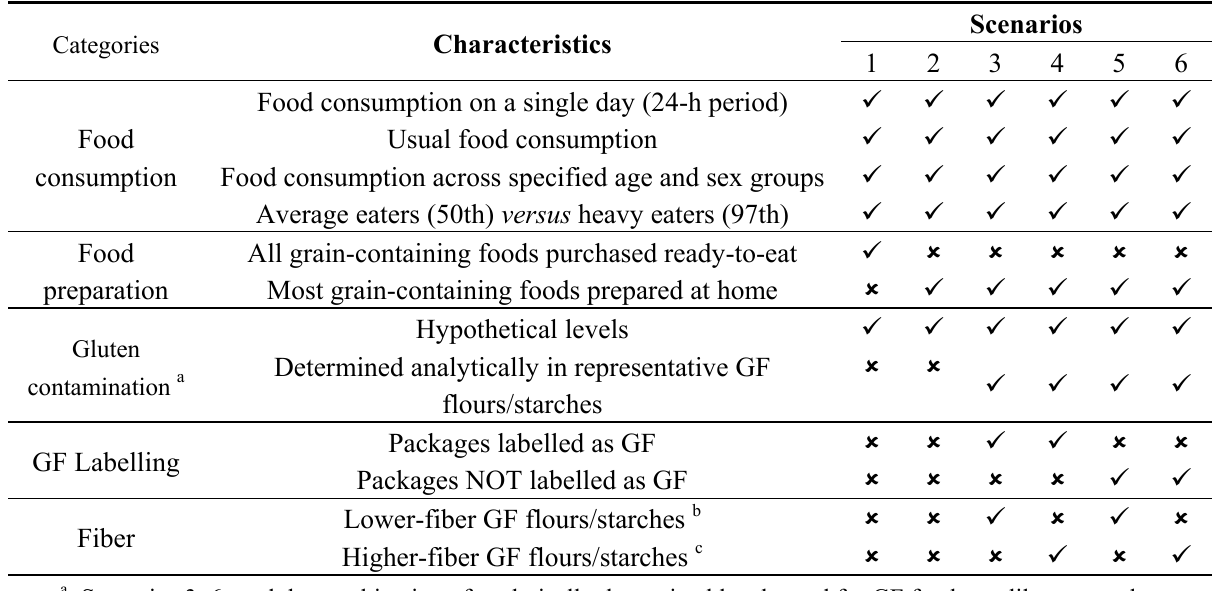
Table 2. Characteristics across which variability in levels of intake of incidental gluten was estimated in Scenarios